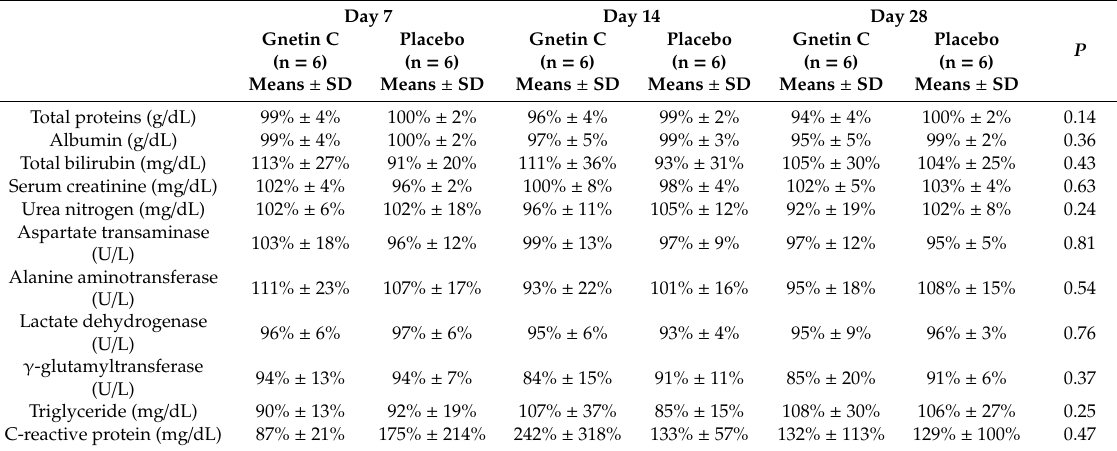
Values are change from baseline. P for interaction of Day